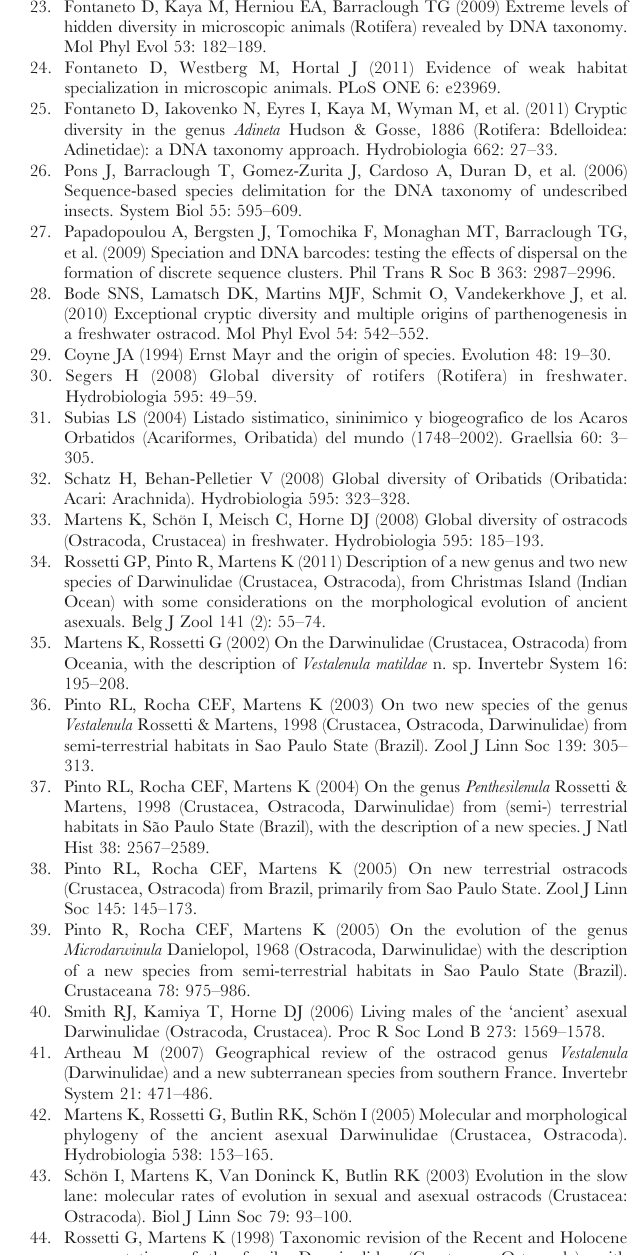
Figure S1 Details of part of the COI phylogeny. The well- supported subclades within the EG species P. brasiliensis Brazil 2 & 3 did not receive species status by the GMYC or the K/ h method. Table S1 Overview of specimens analysed for COI.